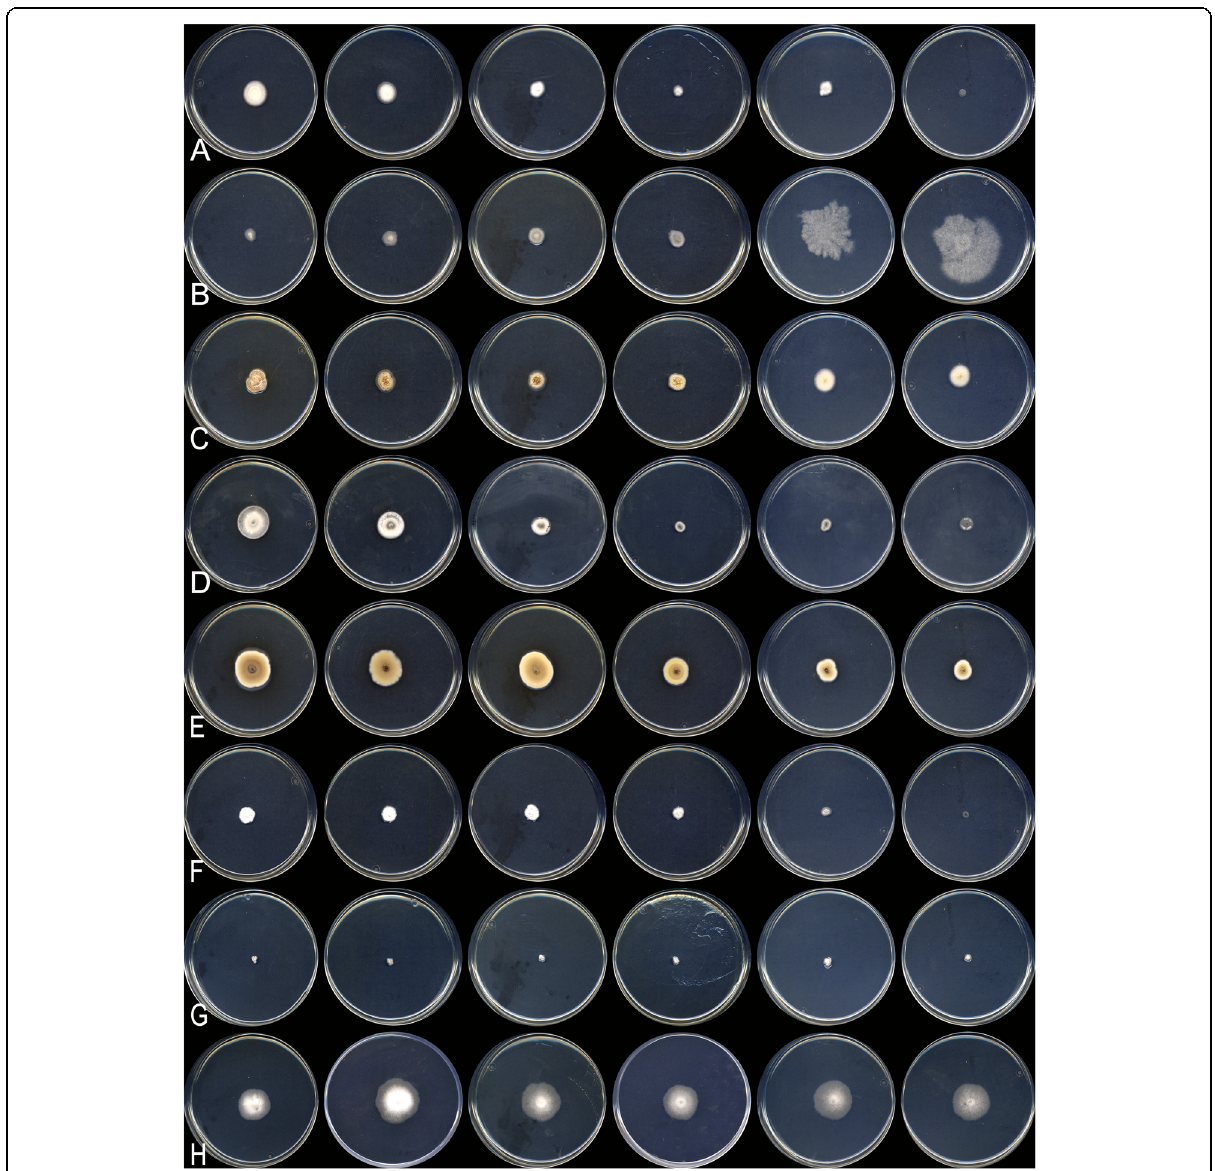
Fig. 12 Relatedness between the growth of the new fungal taxa and the decreasing water activity (a w ) of the culture medium. Surface of the colonies grown on MEA with a w values of 0.97, 0.95, 0.93, 0.92, 0.88 and 0.82 (from left to right, respectively). a Helicoarthrosporum mellicola . b Strongyloarthrosporum catenulatum . c Talaromyces basipetosporus . d Talaromyces brunneosporus. e Talaromyces affinitatimellis . f Oidiodendron mellicola . g Skoua asexualis. h Skoua fertilis (as reference, highly xerotolerant